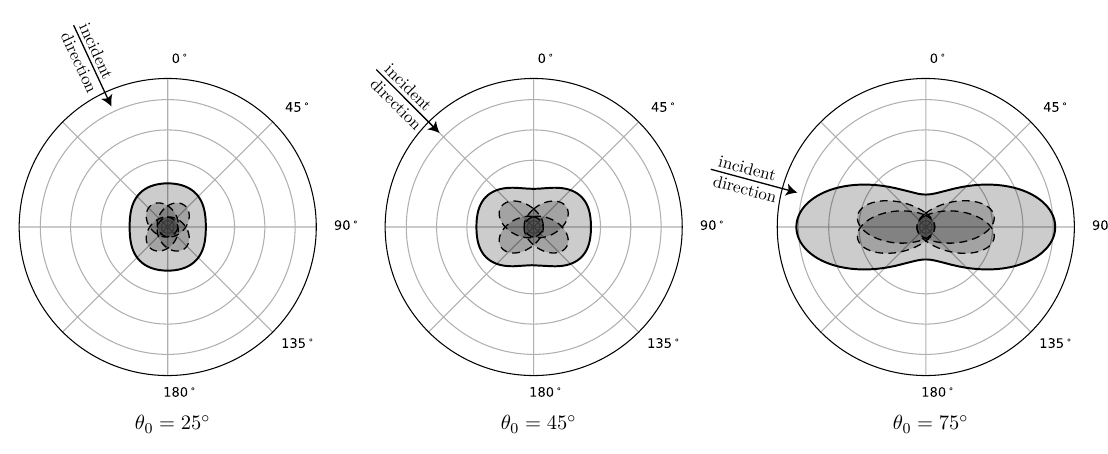
Figure 3. Scattering distribution modelled by a linear combination of 4 generalized Henyey Greenstein Functions (see